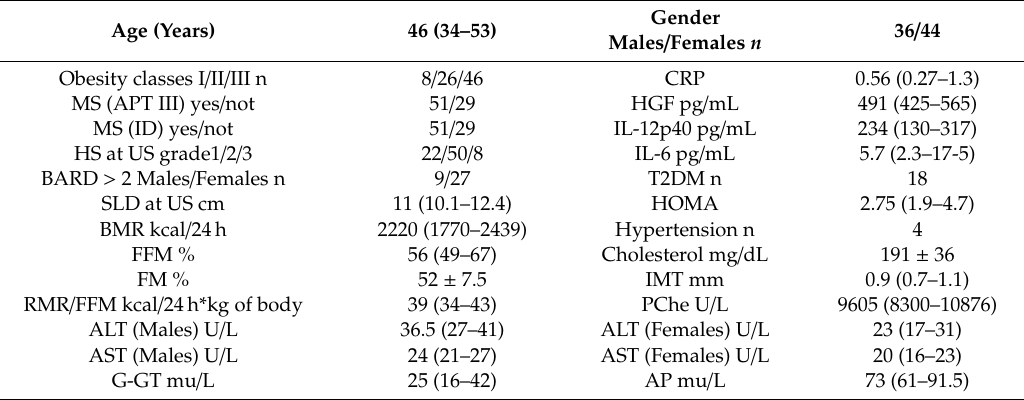
Legend to Table 1: MS, metabolic syndrome; HS at US, hepatic steatosis at ultrasonography; SLD, spleen longitudinal diameter; BMR, basal metabolic rate; FFM, free fat mass; FM, fat mass; RMR, resting metabolic rate; HGF, hepatic growth factor; IMT, carotid intima-media thickness; PChe, pseudo cholinesterase; AP, alkaline phosphatase; G-GT, gamma-glutamyl transpeptidase; AST / ALT, transaminases; CRP; C reactive protein; T2DM, type 2 diabetes mellitus. There was no di ff erence in frequency when relating obesity classes to MS presence, Table 2. Table 2. Relationships between obesity classes and metabolic syndrome (MS) presence.